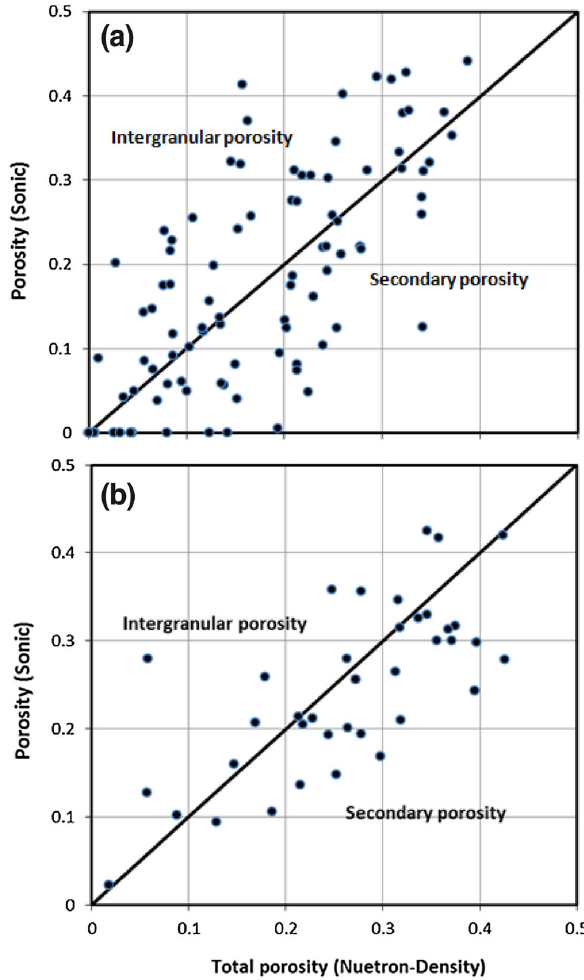
Fig. 4 The secondary porosity indicated from porosity crossplots in a Geisum A-2 and b Tawila N-1